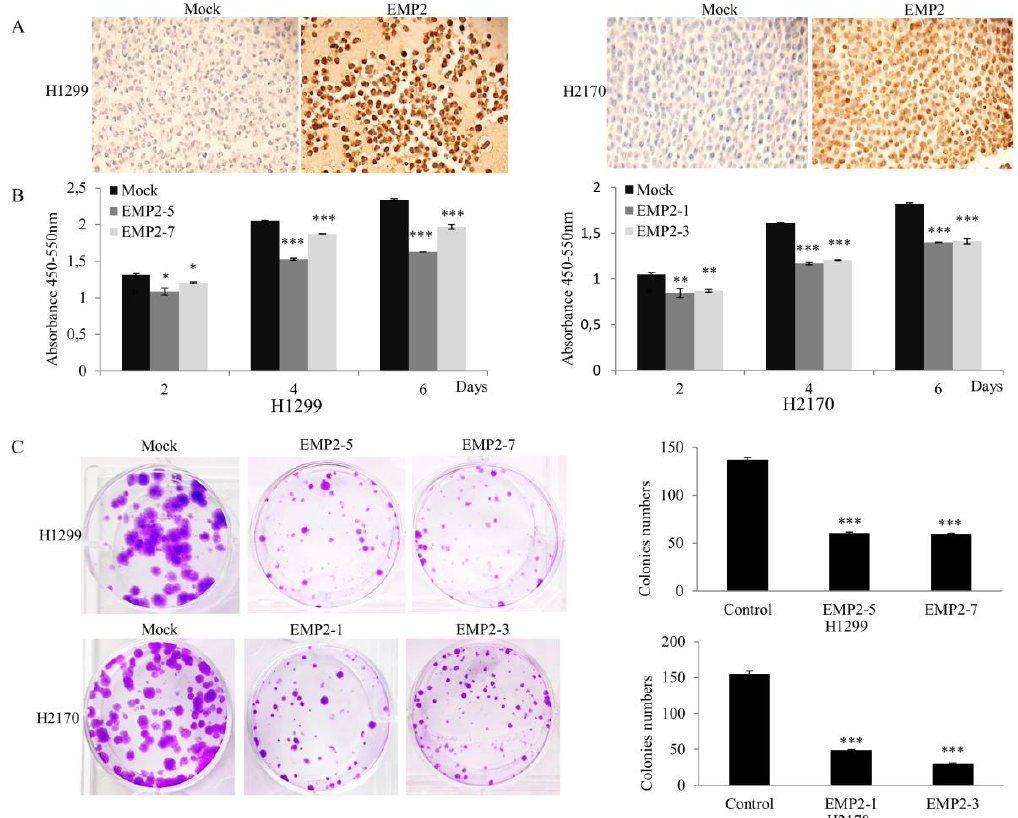
Figure 2. Influence of EMP2 overexpression on NSCLC cell growth. ( A ) EMP2 overexpression in H1299 and H2170 cell lines after stable transfection compared to mock cells was proven by cell-block analysis, confirming a successful transfection of EMP2 (magnification ×200) ( B ) EMP2-positive transfectant cells (EMP2-5 and EMP2-7 for H1299; EMP2-1 and EMP2-3 for H2170) showed significantly reduced cell proliferation compared to mock cells as revealed by BrdU cell proliferation assay. ( C ) Colony formation assay revealed that EMP2 overexpression resulted in significantly decreased colony formation in both H1299 and H2170 cells. The data presented are the means ± SE from three independent experiments. * p < 0.05, ** p < 0.01, and *** p < 0.001 when analyzed with Student ’ s t -test.